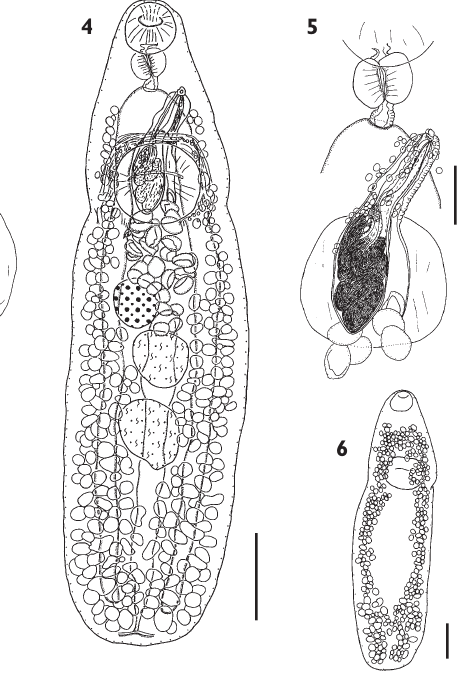
Figs 4-6. Macvicaria shotteri n. sp. ex Sillaginodes punctatus . 4. Whole-mount ventral view. 5. Termi- nal genitalia. 6. Dorsal distribution of vitelline fol- licles. Scale bars : 4, 6, 250 μm; 5, 100 μm.